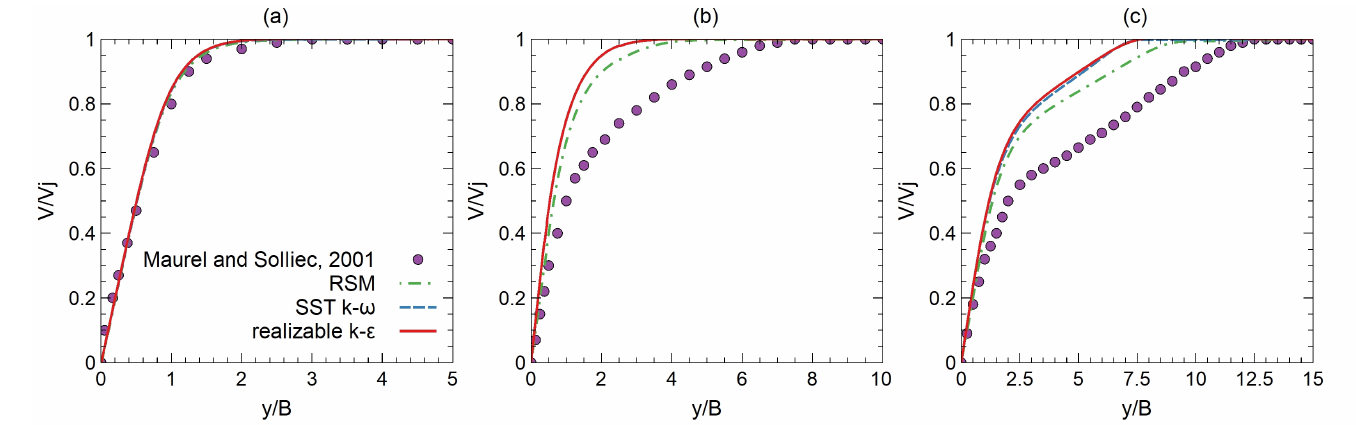
Figure 8. Centerline y velocity component profiles for ( a ) H / B = 5, ( b ) H / B = 10, and ( c ) H / B = 15, compared to reference results reported by Maurel and Solliec